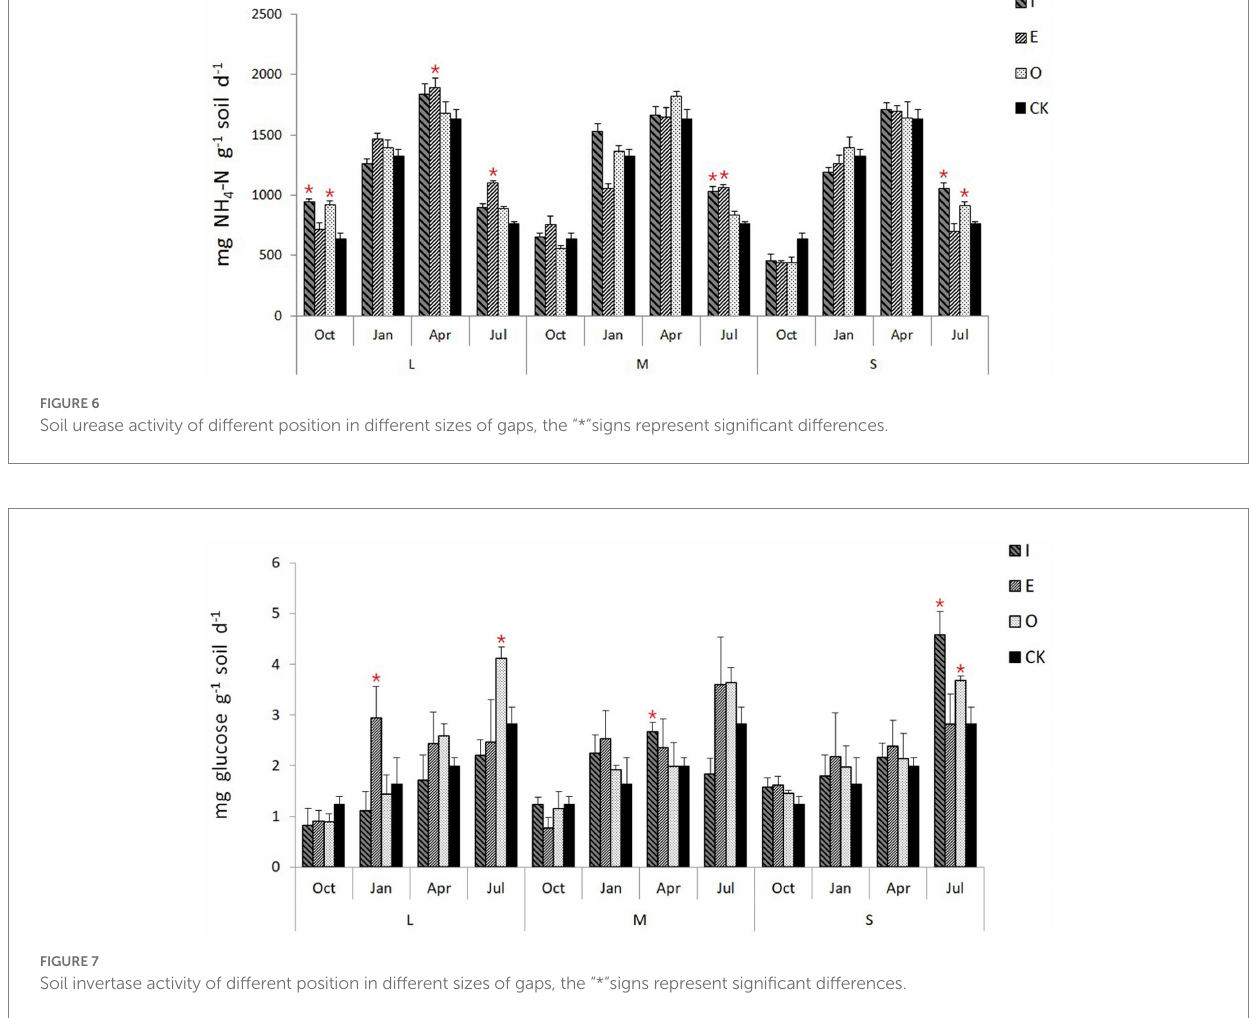
TABLE 2 Correlations between soil chemical properties, MBC, MBN, and enzymatic activity.